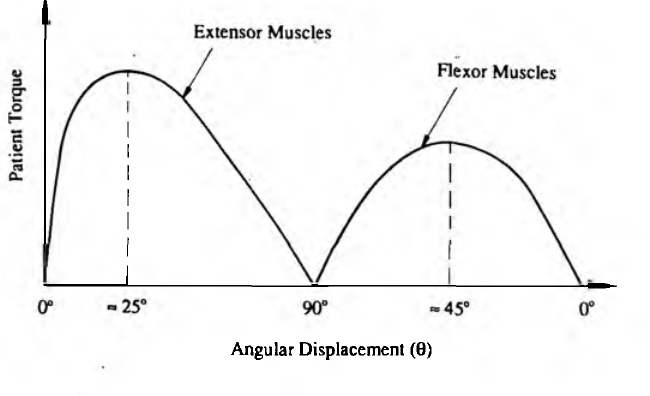
Fig 2: Typical torque versus angle characteristics for the knee joint patient applies a torque Tp to the lever arm. Now the relative position of C to O can be adjusted so as to locate the position of maximum torque developed by the patient at 0=90°. In so doing the patient is required to move the shock absorber through its maximum displacement relative to the limb motion in the region of maximum torque. It is an easy matter to show, and indeed intuitive, that the shock absorber resists with maximum force at this point when the motion is isokinetic. The magnitude of the resisting force, relative to the force of the patient, can then be set by suitably adjusting points A and C or by adjusting the damping capacity of the shock absorber. In this manner the patient’s lower leg can be varied through a spectrum of velocities.